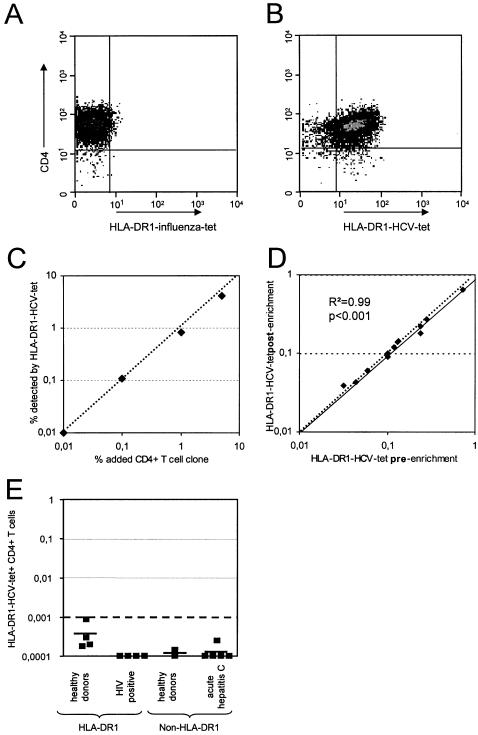
Validation of HLA-DR1-HCV-1806-1818 tetramer staining and enrichment technology.A CD4+ T cell clone specific for HCV 1808-1817 was stained with the HLA-DR1-HCV-1806-1818 tetramer and a control HLA-DR1 tetramer specific for the influenza epitope 307-319 and analysed by flow cytometry as described in the methods (A+B). The HCV clone was derived from patient AR1. Panel C shows staining of the clone diluted serially into PBMC negative for the tetramer at the concentrations shown. Panel D shows a strong correlation between observed pre-enrichment frequency and calculated post-enrichment frequency of HLA-DR1-HCV-tetramer positive CD4+ T cells in all PBMC samples with a frequency of HLA-DR1-HCV-tetramer positive CD4+ T cells of >0.03% (R2 = 0.99, p<0.001). The dotted line is the bisecting line, the solid line represents the trend line of the measured frequencies. Panel E shows the staining of control groups; four healthy and four HIV-infected HLA-DR1 positive individuals, and two healthy individuals and five acute hepatitis C patients without HLA-DR1.